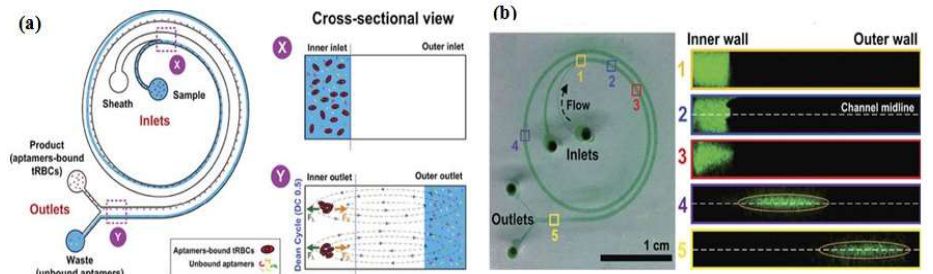
Figure 3. Bi-loop spiral design of inertial microfluidic SELEX (I-SELEX) with dual inlets and outlets. ( a ) The unbound oligonucleotide/any particles migrate towards the outer-side wall (blue color) and are separated with the desired target; ( b ) Numbers 1–5 represent cross sections inside the channel. Fluorescence-labeled aptamer was used to identify each position. Reproduced with permission from reference [19]. Copyright 2015 Macmillan.